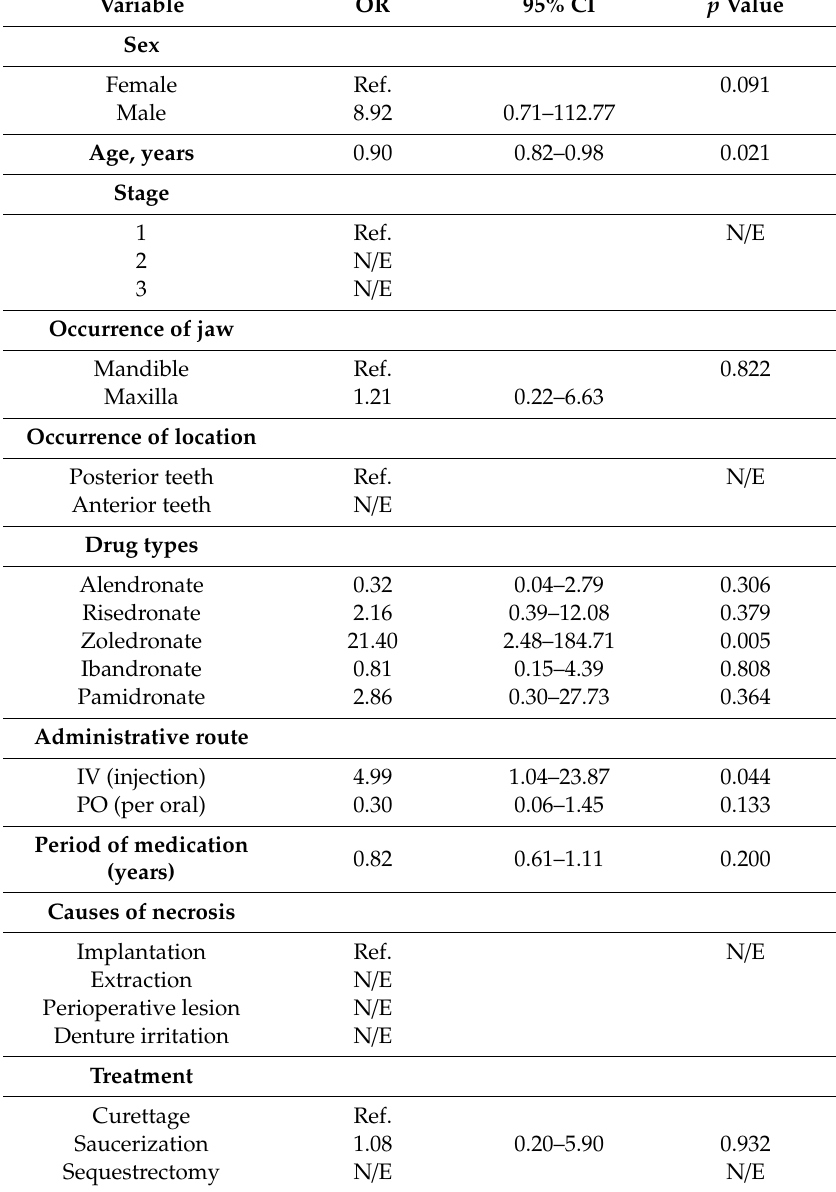
Table 3. Risk Factor analysis by univariate logistic